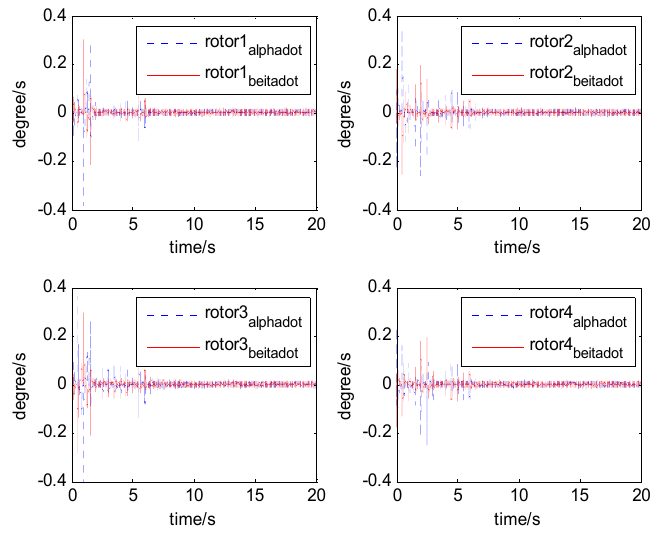
Figure 22. The magnetically suspended rotor angle velocity relative to rotor center before compensation.